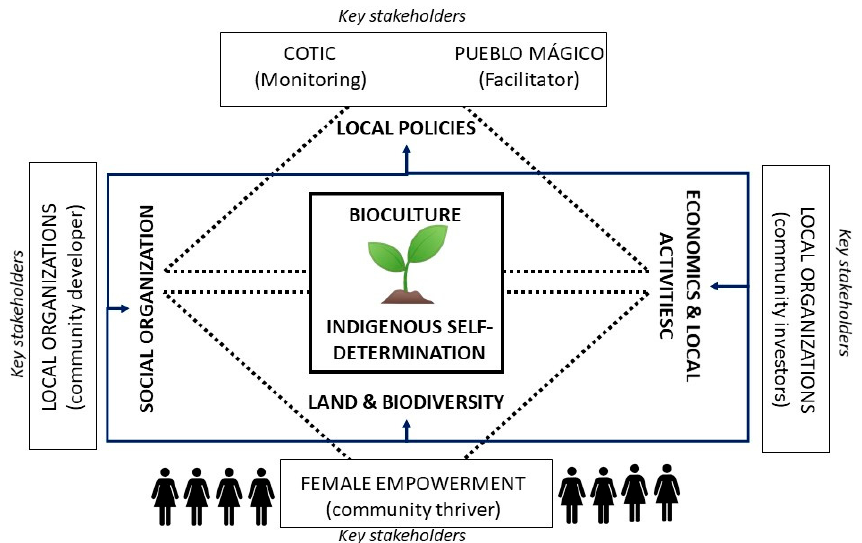
Figure 3. Bioculture and Indigenous self-determination frame for Cuetzalan. Source: Schumacher (2020).